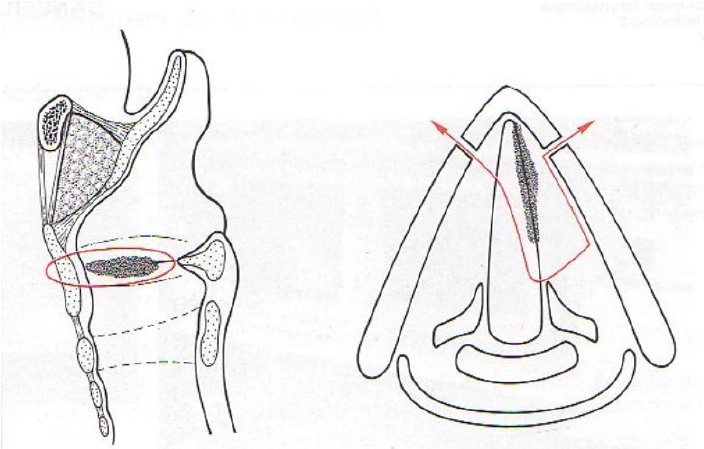
Figure 2. Fronto-lateral laryngectomy. Monobloc resection, removing a vertical fragment of the thyroid cartilage, of the entire vocal cord, of the anterior commissure and of the anterior part of the contralateral vocal cord.